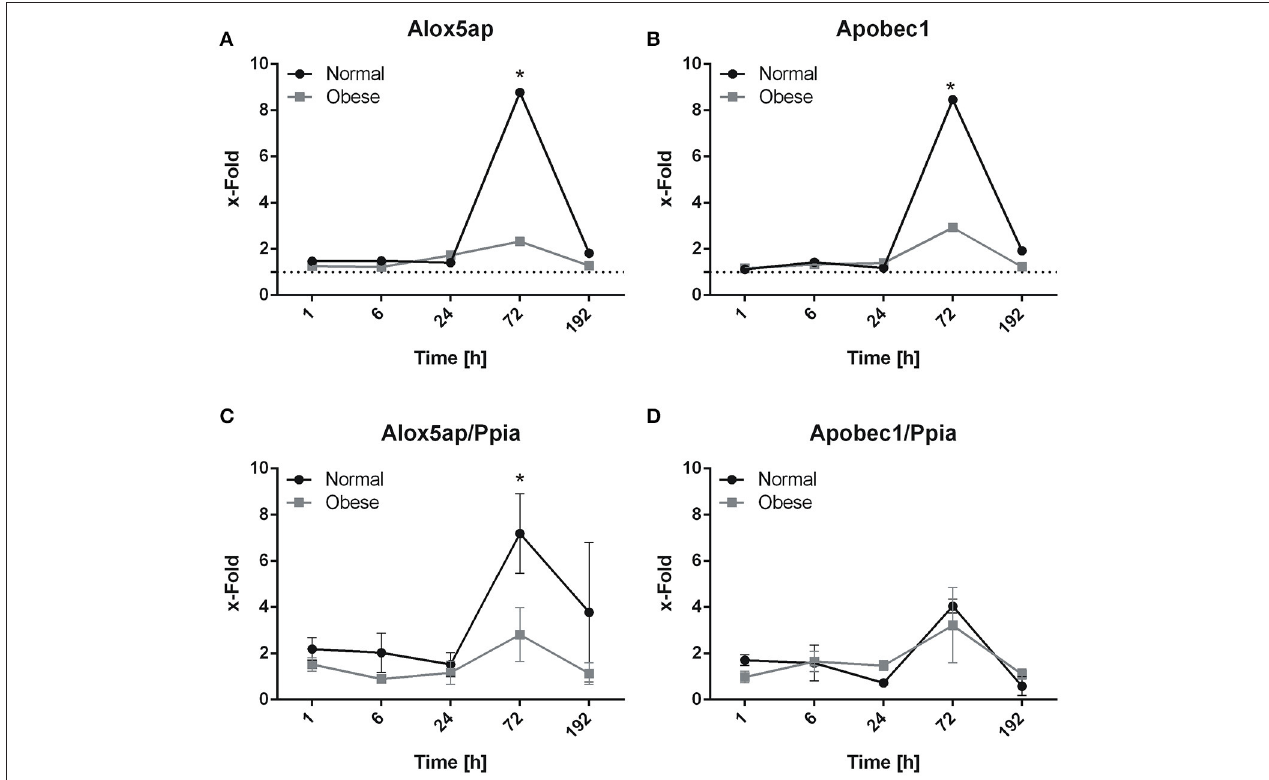
FIGURE 4 | Expression levels of Alox5ap (A) and Apobec1 (B) as determined by microarray analysis. Ticked line(s) at 1 represents basal level. * p ≤ 0.05. Expression levels of Alox5ap (C) and Apobec1 (D) quantified by qPCR. X-fold values ± SEM were determined by normalization on corresponding controls of each time point and diet. Genes show the highest differential expression 3 days post-injury, while obese animals show a lack of response to trauma, overall indicating a direct influence of injury. Apobec1 (D) shows a unidirectional response despite the higher SEM. Both genes show a similar behavior in microarray and qPCR. Significance of qPCR was determined using